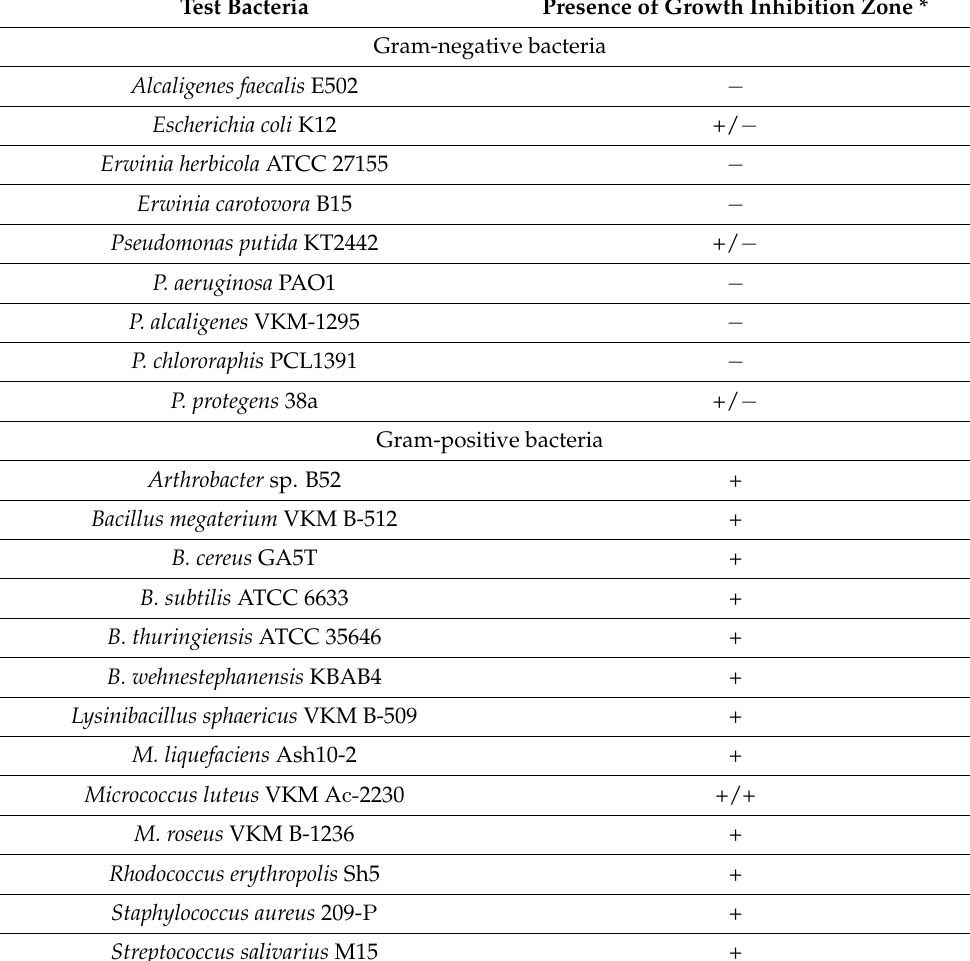
Table 4. Antagonistic activity of the F2E strain. Test Bacteria Presence of Growth Inhibition Zone